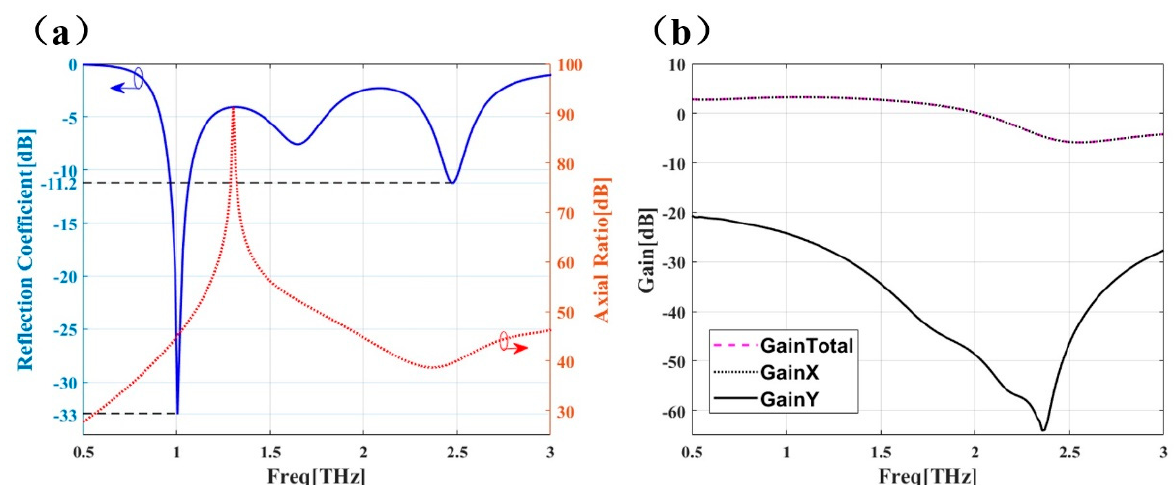
Figure 6. ( a ) Reflectance coefficient and axial ratio of dual-band THz antenna. ( b ) Gain in X and Y directions and total gain of dual-band THz antenna.